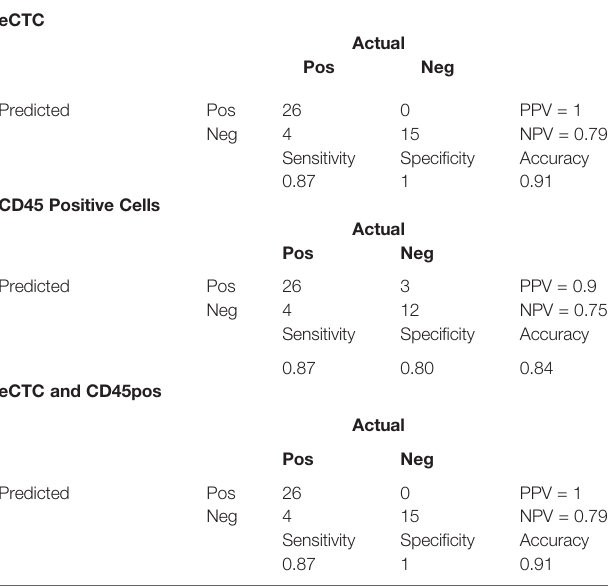
TABLE 6 | Contingency tables of the prediction of bone metastases adopting a machine learning approach taking into consideration only eCTC (top), only CD45-positive cells (middle) or both